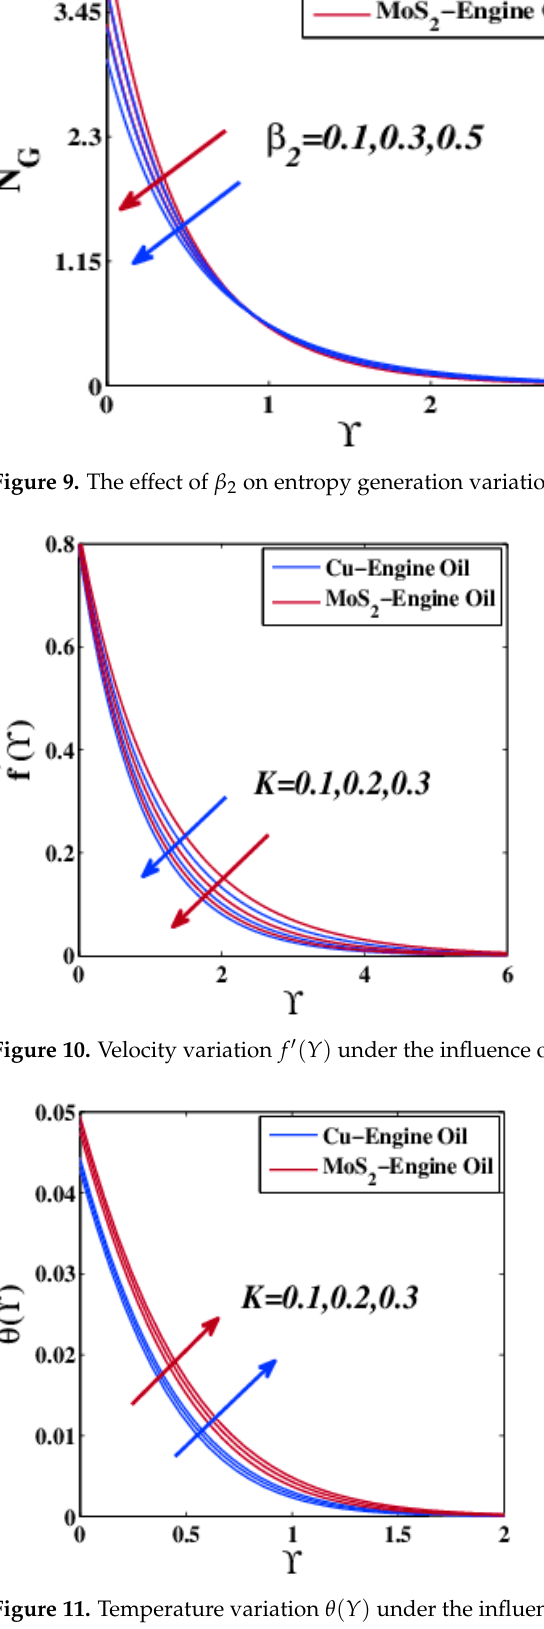
Figure 12. Entropy generation variation 𝑁 (cid:3008) under the influence of 𝐾 . The impact of nanosolid particle size factor 𝜙 on the variations of velocity (Figure 13), temperature (Figure 14), and entropy generation (Figure 15) are depicted against boundary layer thickness 𝛶. The parameter 𝜙 causes an increase in the variations of tem- perature 𝜃(𝛶) and entropy generation 𝑁 (cid:3008) because an increment in 𝜙 causes the density of the nanofluid to increase. As a result, two effects co-occur: (a) a decreasing simultane- ous velocity and (b) an increasing thermal conductivity and simultaneous temperature.